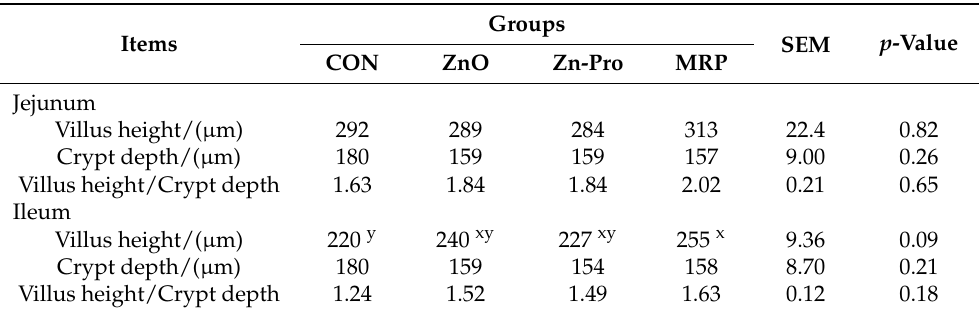
Table 5. Effects of different treatments on intestinal morphology in the different groups on d 28 of experiment.